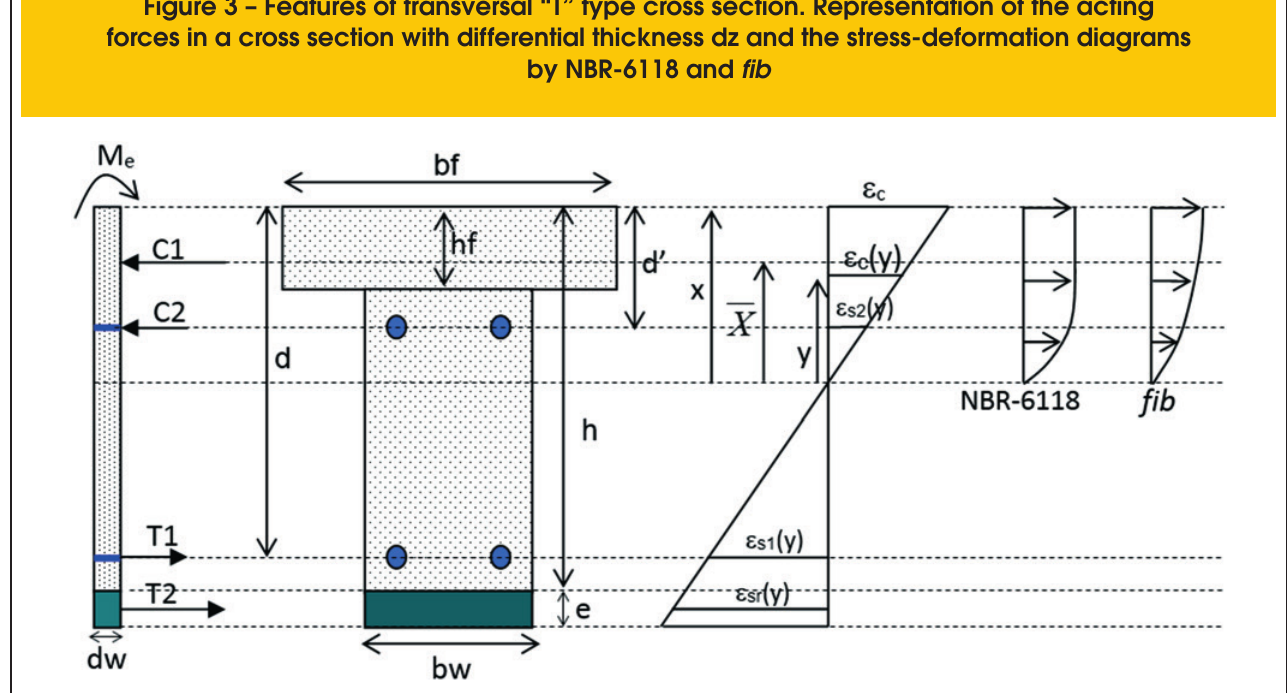
Figure 3 – Features of transversal “T” type cross section. Representation of the acting forces in a cross section with differential thickness dz and the stress-deformation diagrams by NBR-6118 and